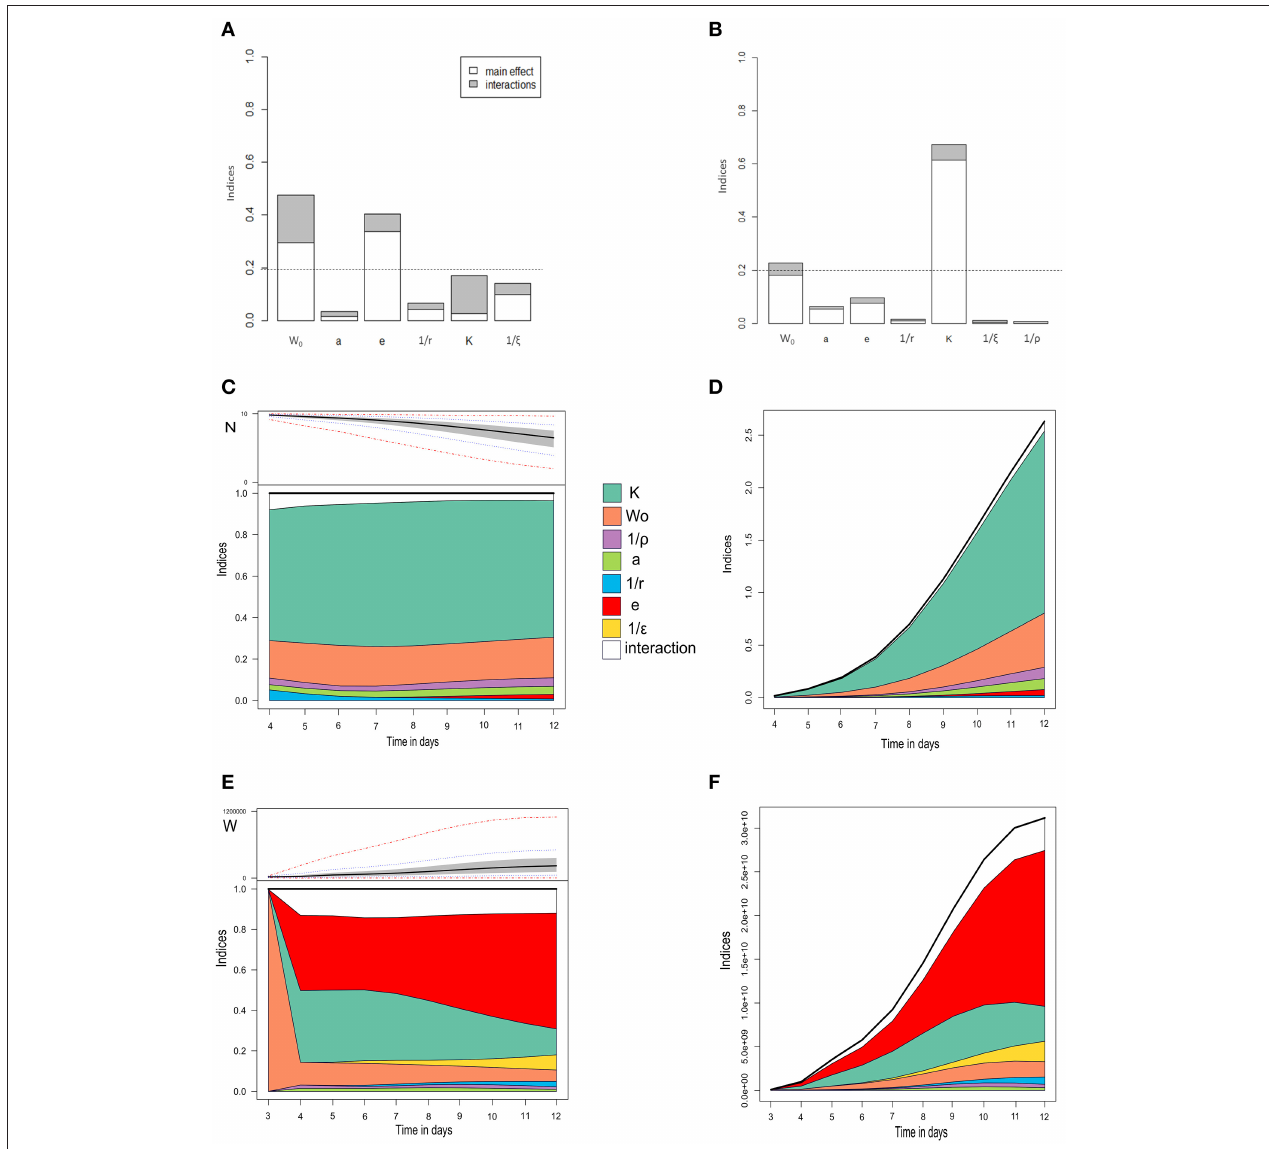
FIGURE 4 | Global sensitivity analysis of three model outputs. (A) The basic reproduction number R 0 . (B) Maximum prevalence. (A,B) Main effects are in white, interactions in gray. The horizontal dotted line is the significance threshold (20% of variance). (C,D) Number of surviving oysters over time, with normalized (C) and non-normalized sensitivity indices (D) . (E,F) Bacterial concentration in seawater over time, with normalized (E) and non-normalized sensitivity indices (F) . In (C) and (E) , the upper subplots show the extreme (red dash-and-dot curves), percentiles (dotted blue curves), interquartile areas (gray), and median (bold curves) output values at every time point, while the lower subplots show sensitivity indices at every time point for main effects and interactions. W 0 , initial bacterial concentration; a,rate of exposure to seawater; e, bacteria shedding rate; 1/r, infectious period; K, half-infective dose; 1/ ξ , free-living bacteria lifetime in